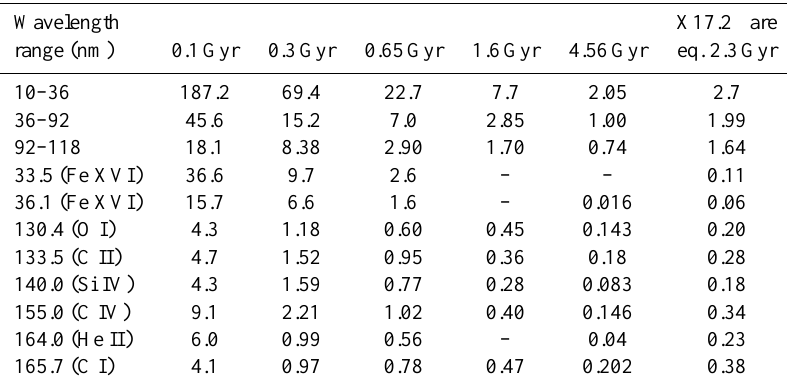
Table 1. Integrated fluxes of different solar analogues (Ribas et al., 2005) and a corresponding 2.3Gyr old solar proxy determined from the